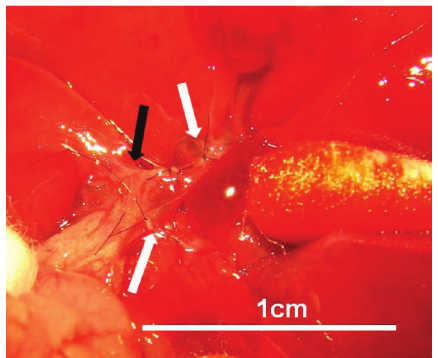
Figure 1. Photograph showing the ligation and section of the median, left lateral, and caudate liver lobe ducts. Note that the bile duct of the right lateral lobe was left intact (black